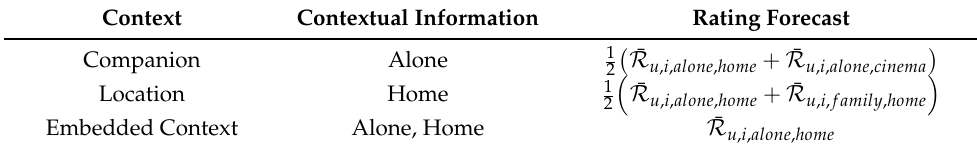
Table 4. Summary of the typologies of rating forecasts based on evaluated contextual